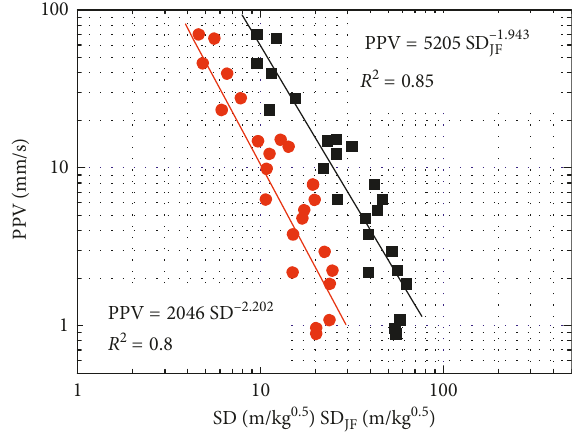
Figure 11: Relationships between PPV and SD and SD